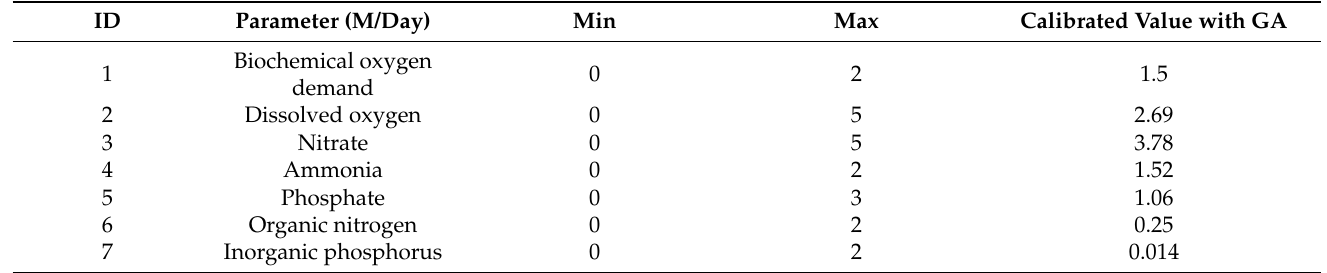
Table 10. Values of calibrated parameters in the QUAL2KW model using the genetic algorithm based on boundary conditions for this parameter.